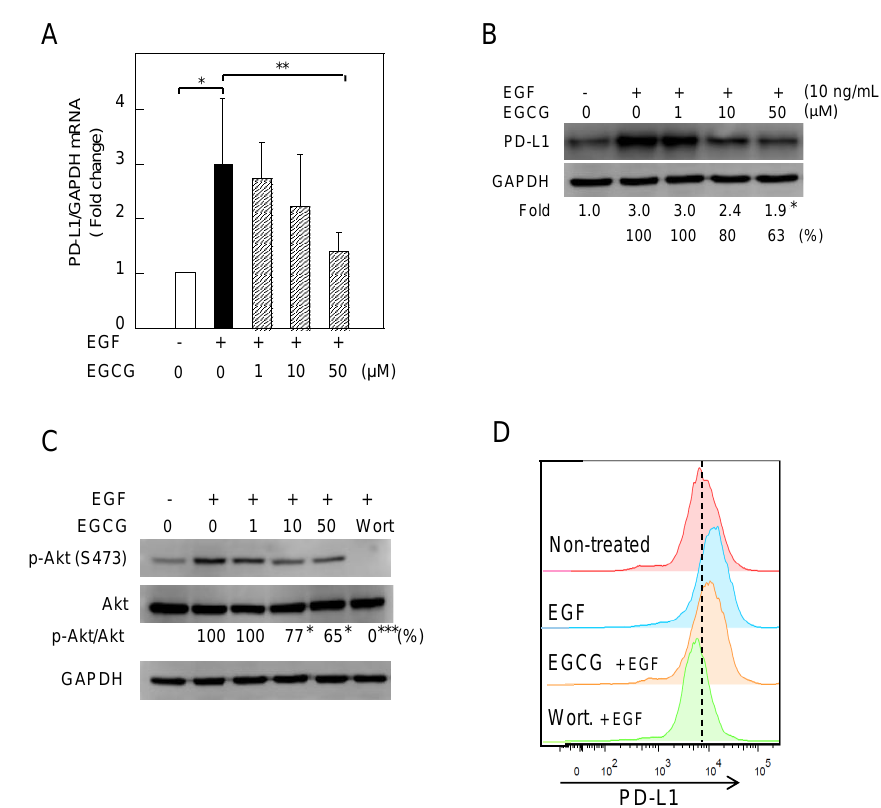
Figure 3. Downregulation of EGF-induced PD-L1 protein and inhibition of Akt phosphorylation in Lu99 cells treated with EGCG. ( A ) PD-L1 mRNA expression, ( B ) PD-L1 protein, ( C ) phosphorylation of STAT1 and Akt, and ( D ) cell-surface PD-L1. “ − “ and “+” indicate in the absence or presence of EGF (10 ng/mL). Numbers indicate average percentage compared with EGF-treated cells. * p < 0.05, ** p < 0.01, *** p < 0.001.